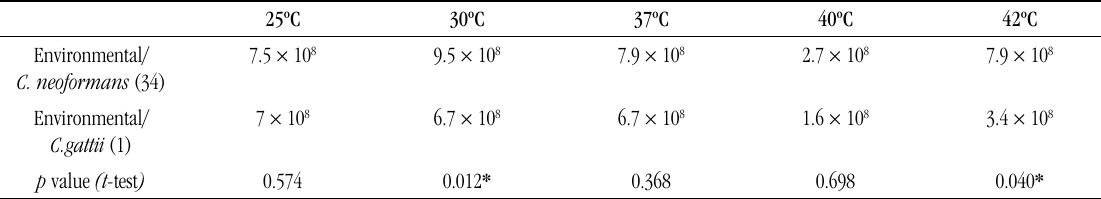
tABLE 3 – Mean microorganism concentrations in the seventh day of thermotolerance reading with only environmental